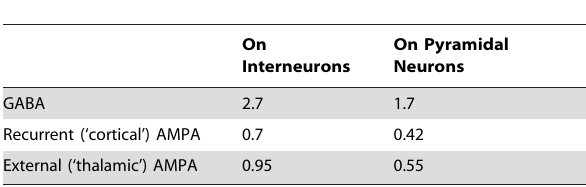
Table 2. Synaptic efficacies